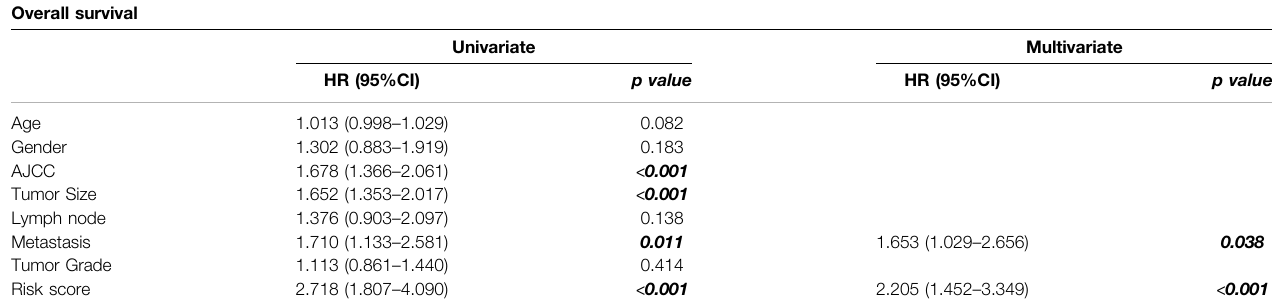
TABLE 1 | Univariate and multivariate analysis. Highlight the signi fi cant p value. Overall